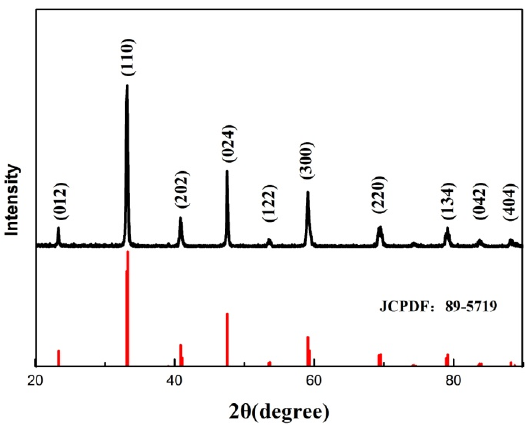
Figure 4. X-ray di ff raction (XRD) patterns of LSC. Figure 4. X-ray diffraction (XRD) patterns of LSC. Figure 4. X-ray diffraction (XRD) patterns of LSC.